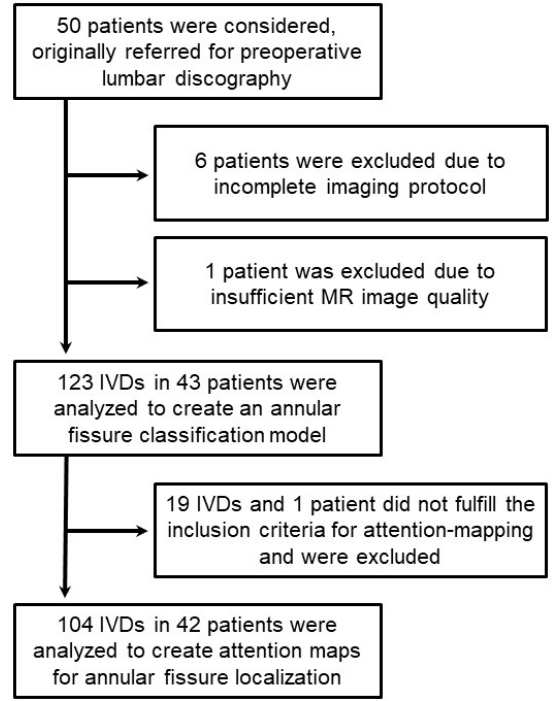
Figure 2. Patient flowchart. IVD = intervertebral disc; MR = magnetic resonance.